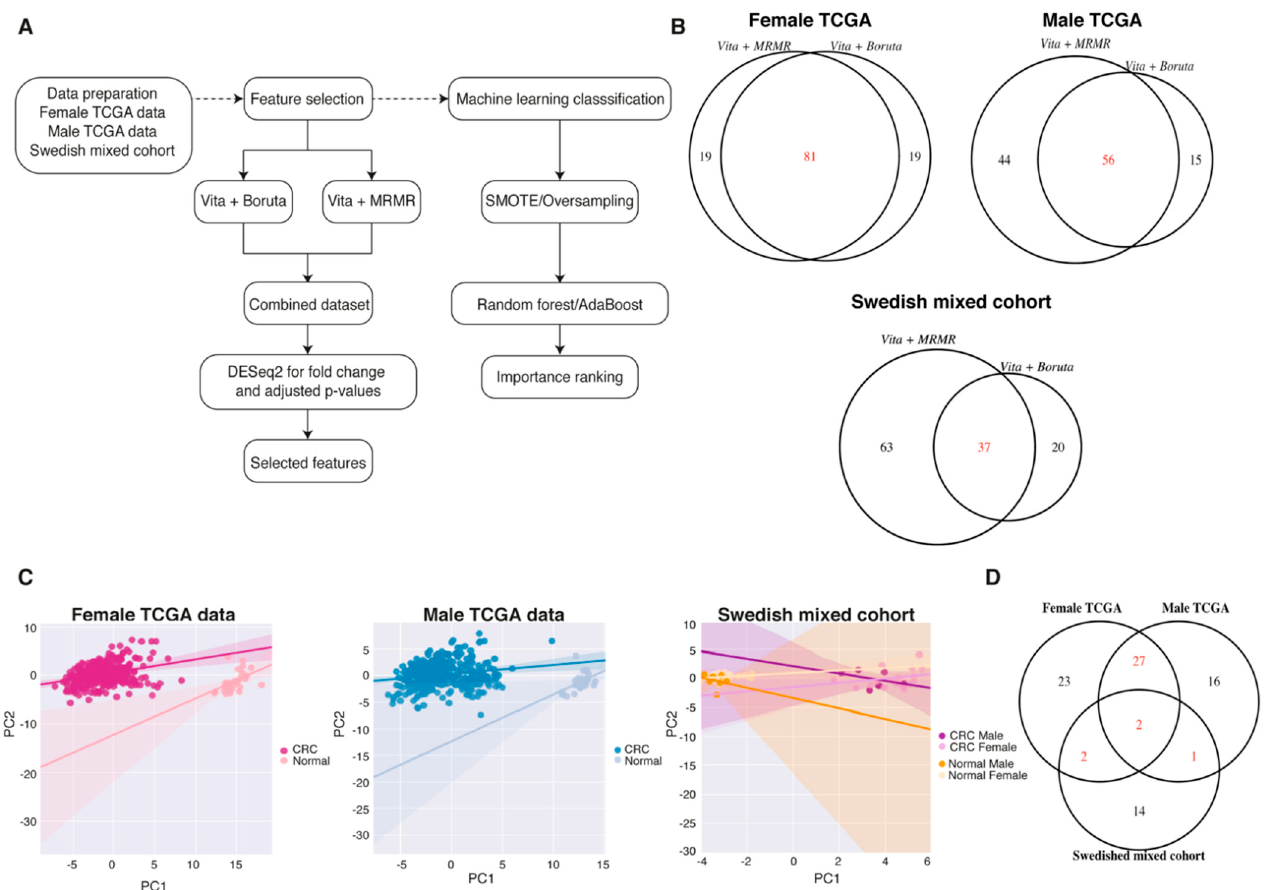
Figure 3. Half of the biomarkers obtained with feature selection were sex-specific. ( A ) The data-analysis pipeline for feature selection and machine learning to find the top-ranked biomarkers. ( B ) Venn diagram showing the common features selected with Vita + Boruta and Vita + MRMR. ( C ) Principal component analysis showing the separation between normal and CRC in the different datasets. ( D ) Venn diagram showing the common features between the different datasets.